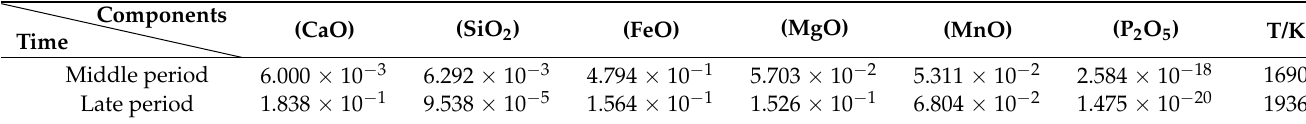
Table 8. Activities of components in